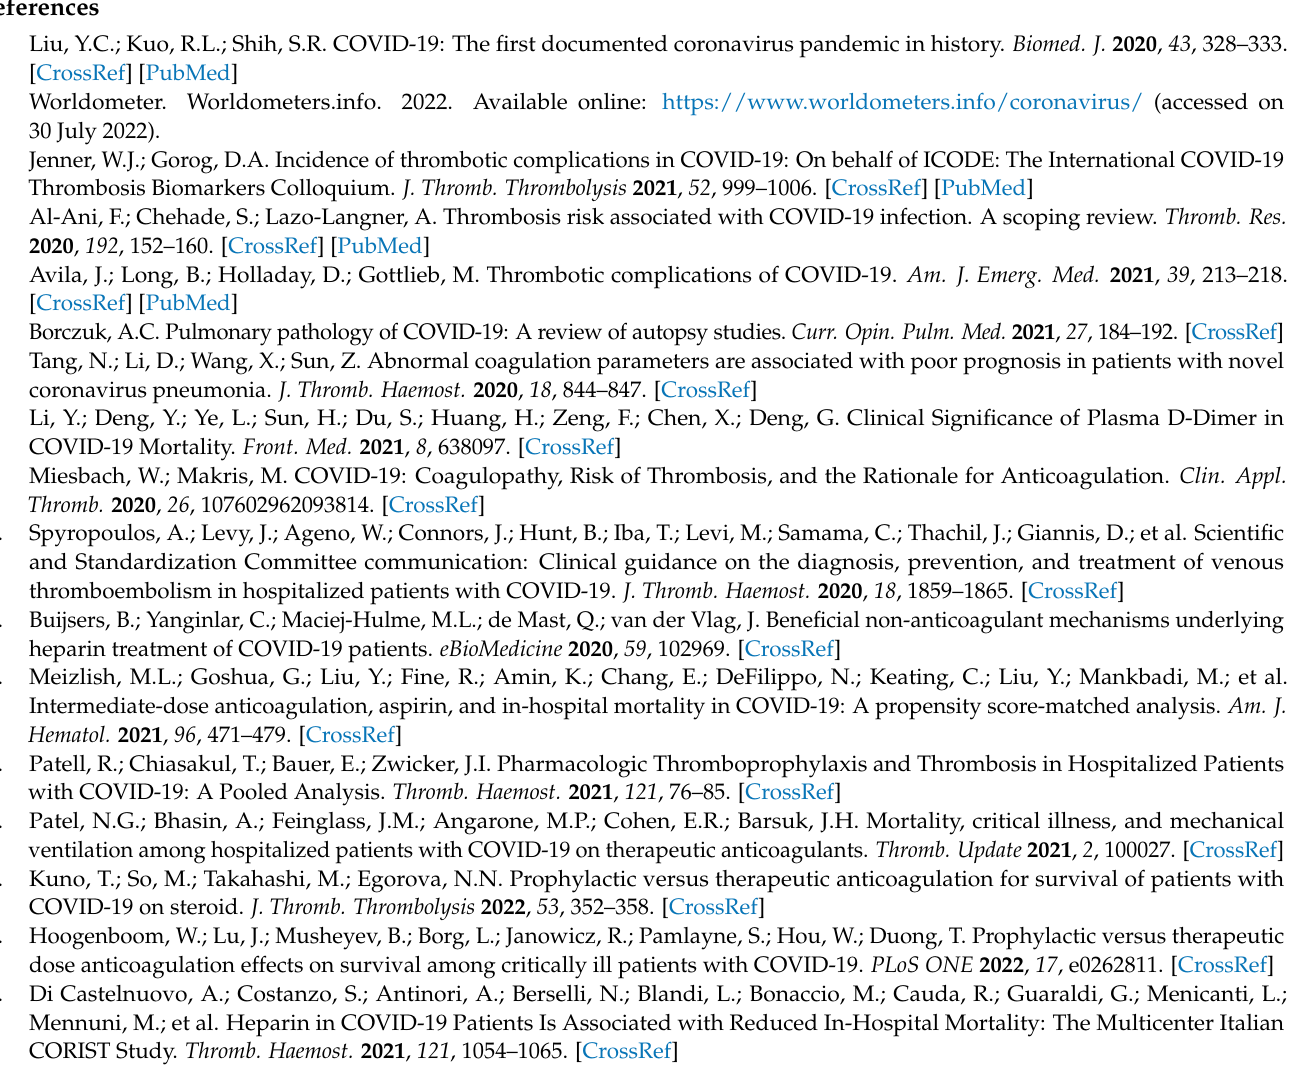
doses, Figure S11: Major bleeding events in cohorts with different disease severity, Figure S12: Major bleeding events in cohorts with different anticoagulant doses, Figure S13: The need for invasive mechanical